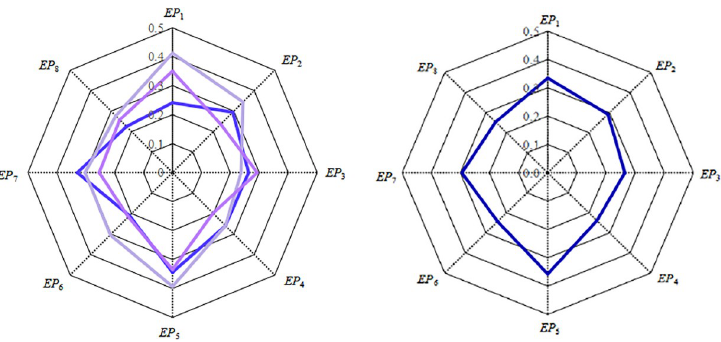
Fig 6. The importance of engineering property indexes. a. The importance of muti-agent. b. The importance means.